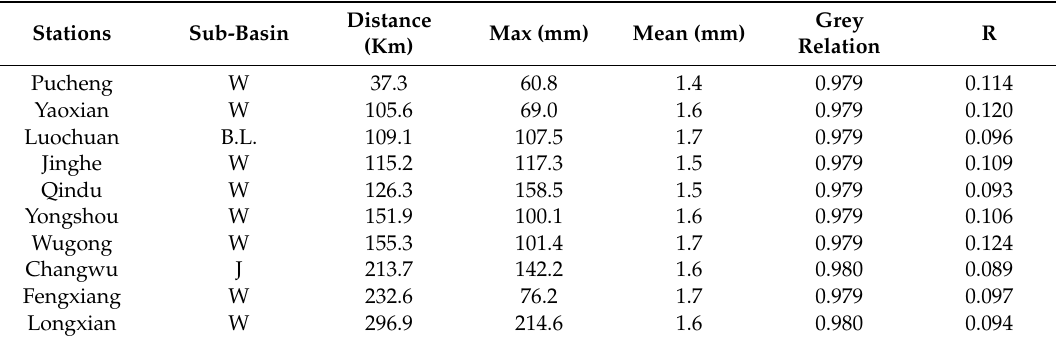
Table 2. A summary of the rainfall data at meteorological stations.